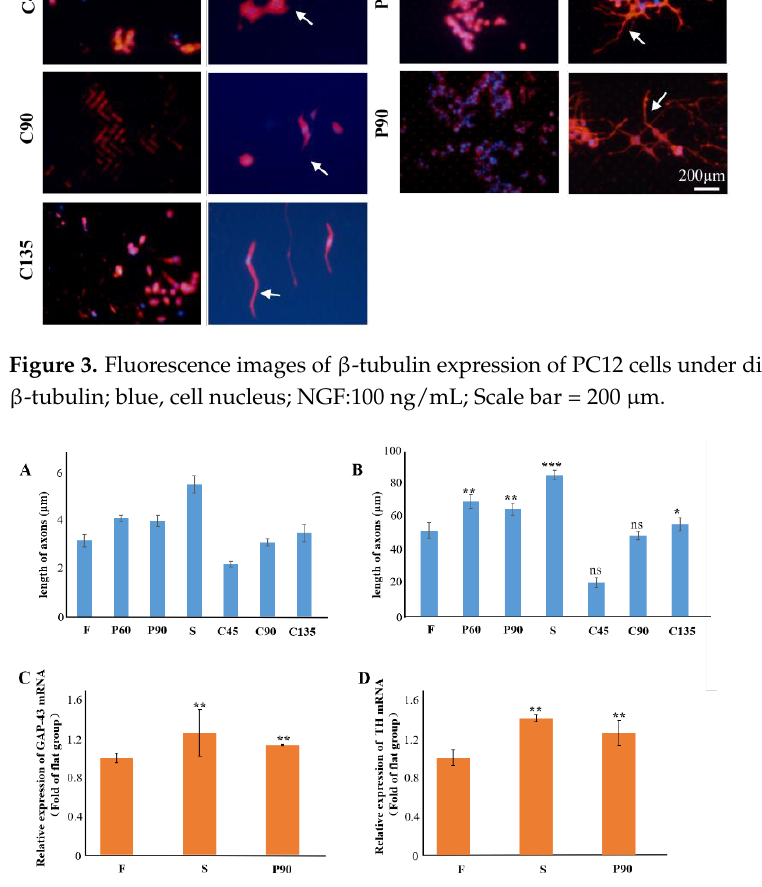
Figure 4. ( A ) Histogram of axon length of PC12 cell on different topographies after 5 days. ( B ) His- togram of axon length of PC12 cell on different topographies after NGF treatment for 5 days. ( C ) Gene expression of GAP-43 of PC12 cell on different topographies after NGF treatment for 3 days. ( D ) Gene expression of TH of PC12 cell on different topographies after NGF treatment for 3 days. NGF: 100 ng/Ml, GAPDH refers to the internal parameter, * p < 0.05, ** p < 0.01, *** p < 0.001. The data is the mean value of each parameter for each experimental condition.